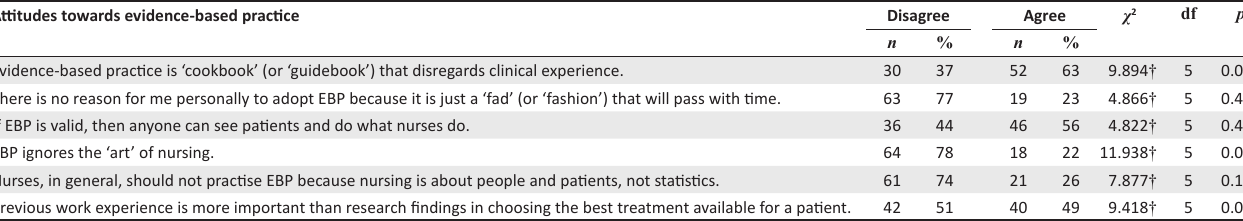
TABLE 2: Self-reported attitudes towards evidence-based practice. Attitudes towards evidence-based